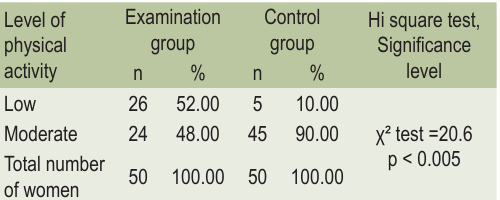
TABLE 1. Level of physical activity of women without es- trogen de fi ciency and statistical signi fi cance of difference in the level of physical activity between examination and control group